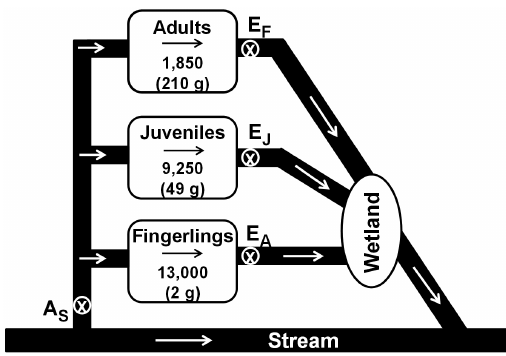
Figure 1. Schematic drawing of the trout farming system located in the Serra da Bocaina (SP), organized into three sectors, with the number of individuals and the average weight, where: A (affluent of the production system); S E (effluent of the fingerlings sector); E (effluent of F J the juveniles sector); E (effluent of the adults sector); A arrows = directional flow of water in the production